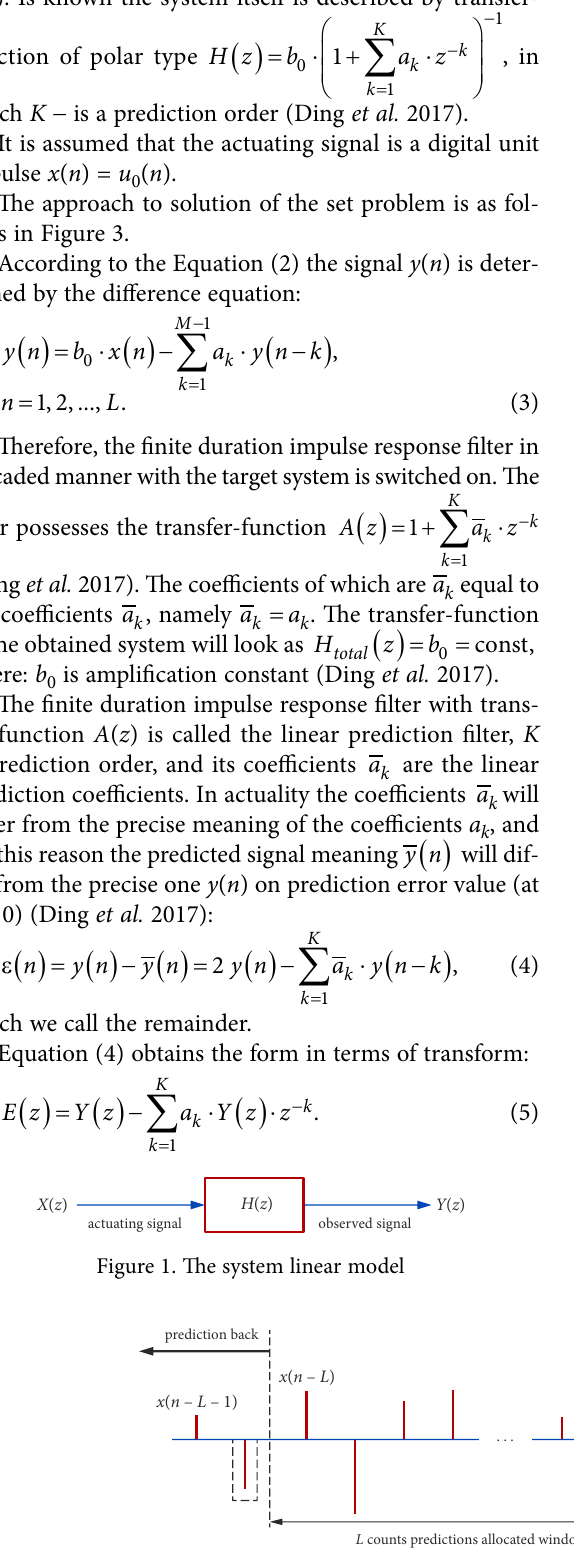
Figure 2. Prediction backward and forward (the appropriate readouts, which are predicted and outlined with dot